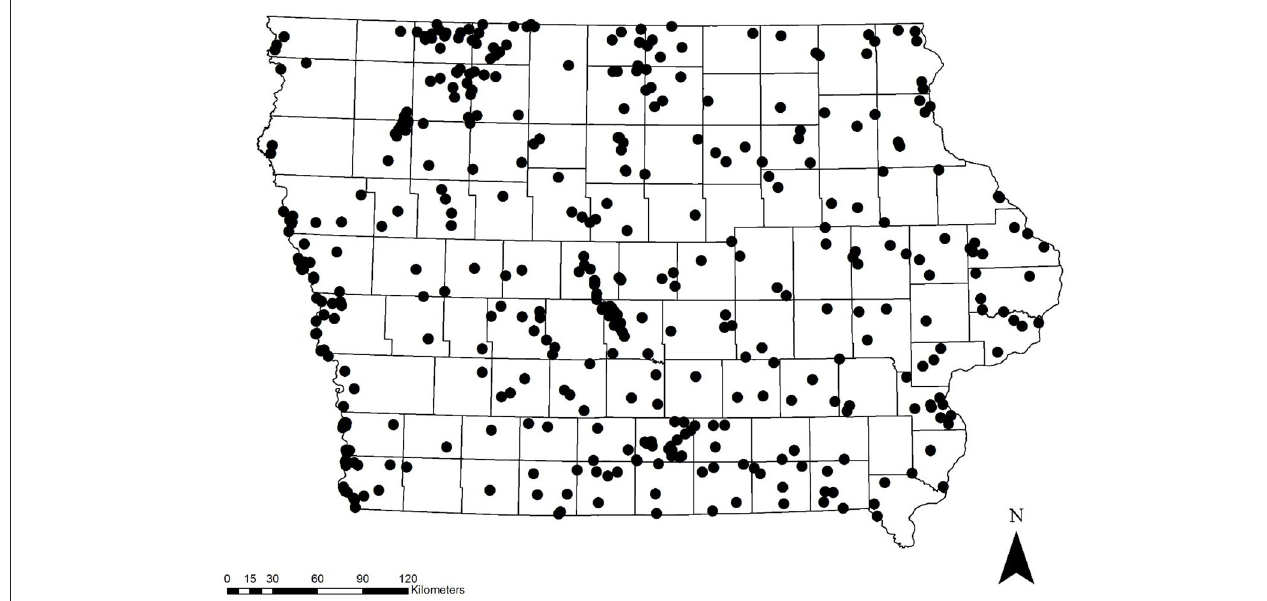
FIGURE 1 | Map of site locations for monarch surveys in Iowa,